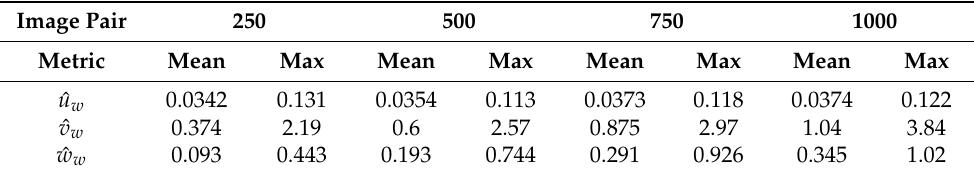
Table 17. Percentage difference of computed displacements between ADIC3D and DICe. Image Pair 250 500 750 1000